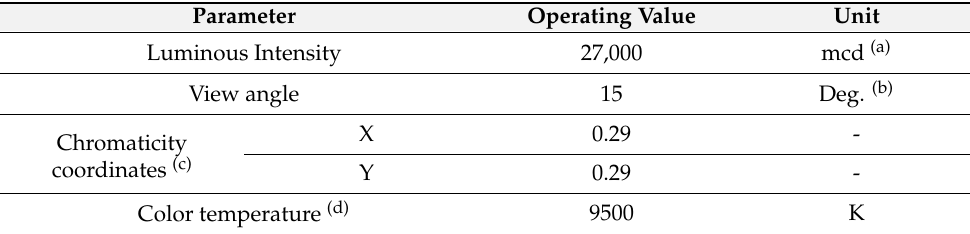
Figure 1. ( a ) Flow chart of the sludge settling test device. ( b ) Photo of the sludge settling test device set. Table 1. Electrical and optical characteristics (Ta = 25 ◦ C). Table 1. Electrical and optical characteristics (Ta = 25 °C ).